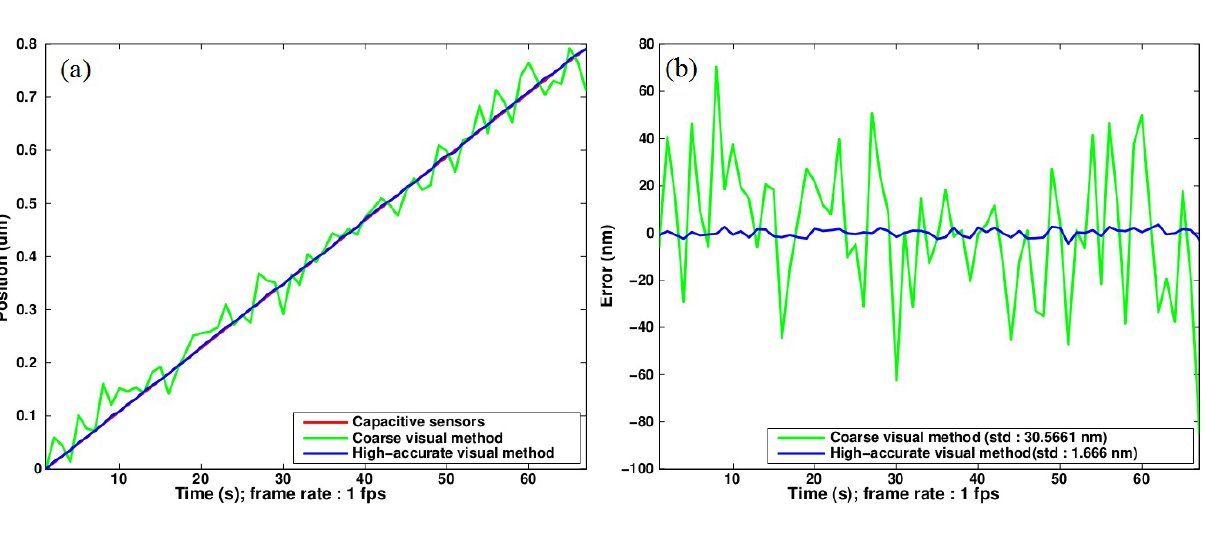
Figure 11. Measurement of linear displacement of the pattern. 780 × 580 pixels image. ( a ) Reconstructed positions; ( b ) Deviation from a straight